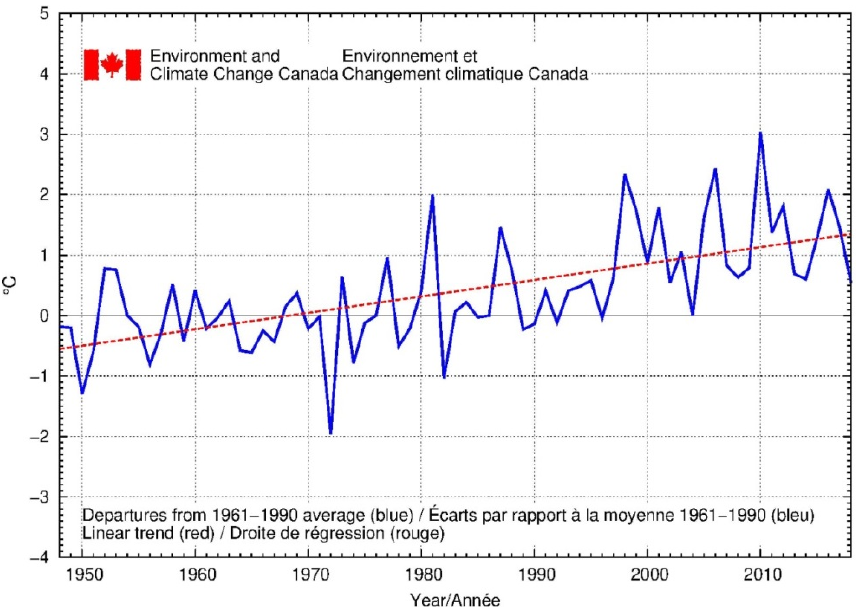
Figure 2. Nationally averaged annual temperature anomalies with reference to recorded temperatures over 1948–2018 [2].